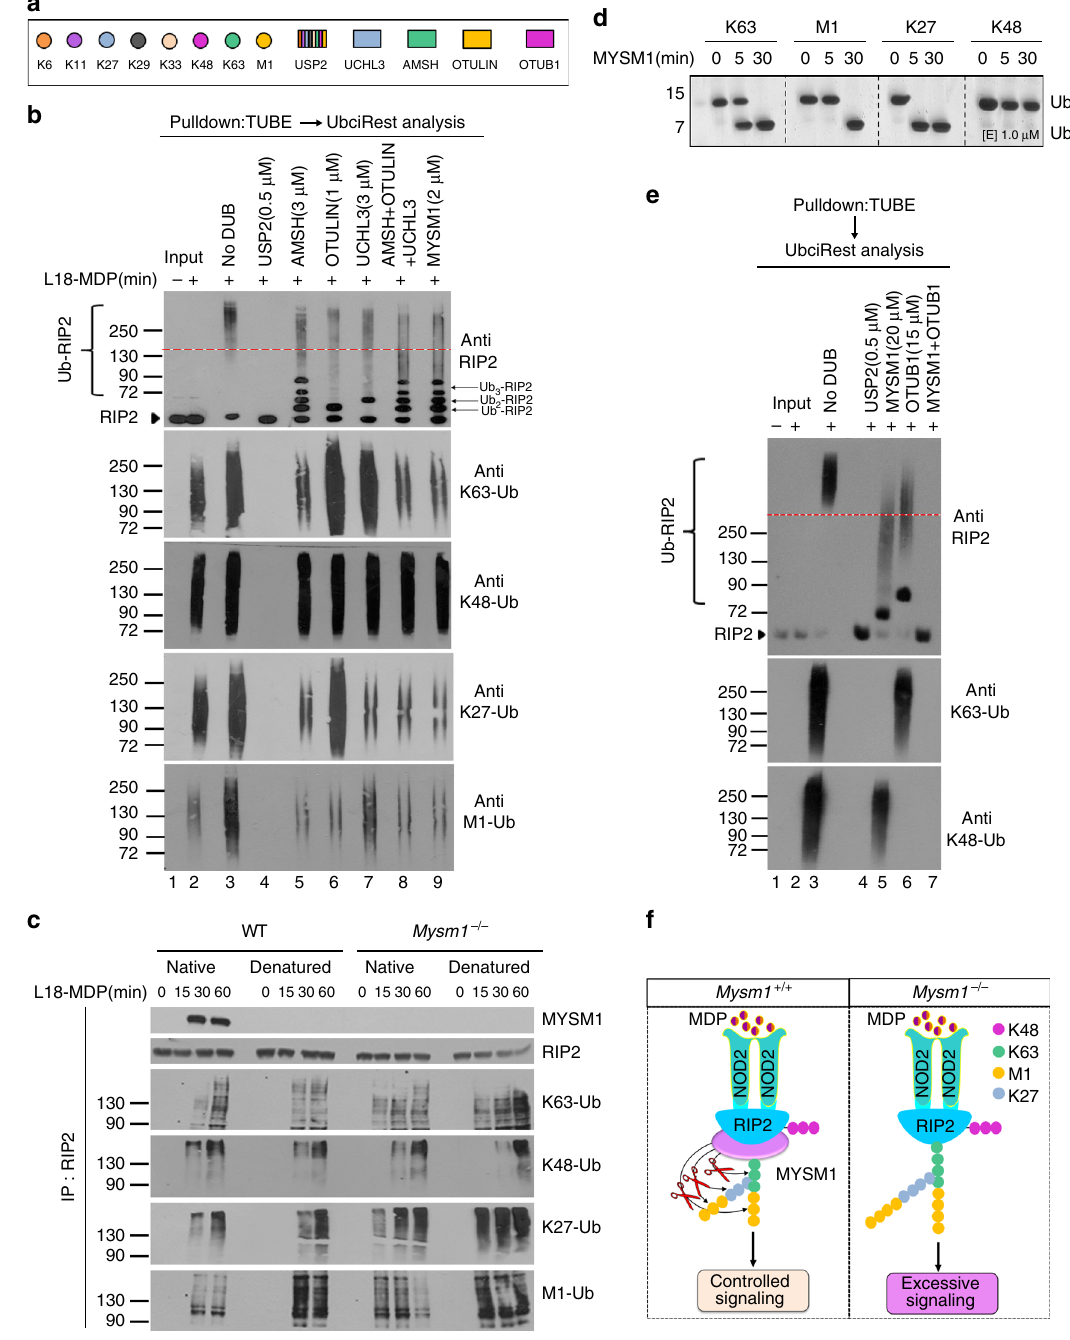
Fig. 5 MYSM1 disrupts the NOD2:RIP2 complex by removing K63, K27, M1 but not K48 polyubiquitins. a Color codes of ubiquitin linkage speci fi city of DUBs used in the UbiCRest analysis ( b, e ). b TUBE pulldowns from BMDMs stimulated with L18-MDP (1 h) were subjected to UbiCRest then immunoblotted for RIP2, K63, K48, K27, and M1 polyubiquitin chains. The red dashed line is an arbitrary line highlighting a relative shift from high to lower MW intermediate /complete digestion products of Ub-RIP2. c Native and denatured cytoplasmic fractions from WT and Mysm1 − / − BMDMs stimulated with L18-MDP for indicated duration were immunoprecipitated with anti-RIP2 and pulldowns were immunoblotted for indicated molecules. d Ubiquitin linkage speci fi city of MYSM1. Di-ubiquitins of indicated linkages incubated with recombinant MYSM1 were separated by SDS-PAGE gel and visualized by silver-staining. e TUBE pulldowns from WT BMDMs stimulated with L18-MDP for 1 h were incubated with higher concentration of the indicated DUBs for 3 h. Samples were then immunoblotted for RIP2, K63, and K48 polubiquitin chains. The dotted red lines ( b, e ) are arbitrary lines indicating a relative shift from high to lower MW Ub-RIP2 forms after digestion. Note that for maximum Ub restriction, in e , a higher concentration of DUBs was used compared to b . f Schematic of proposed model for removal of polyubiquitins from RIP2 by MYSM1. Data are representative of two to six independent experiments.